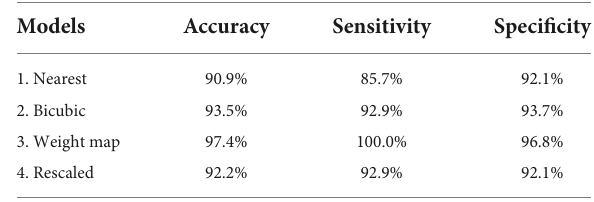
TABLE 4 Accuracy, sensitivity, and specificity of the established best models trained with different types of image networks and images constructed through varying feature engineering